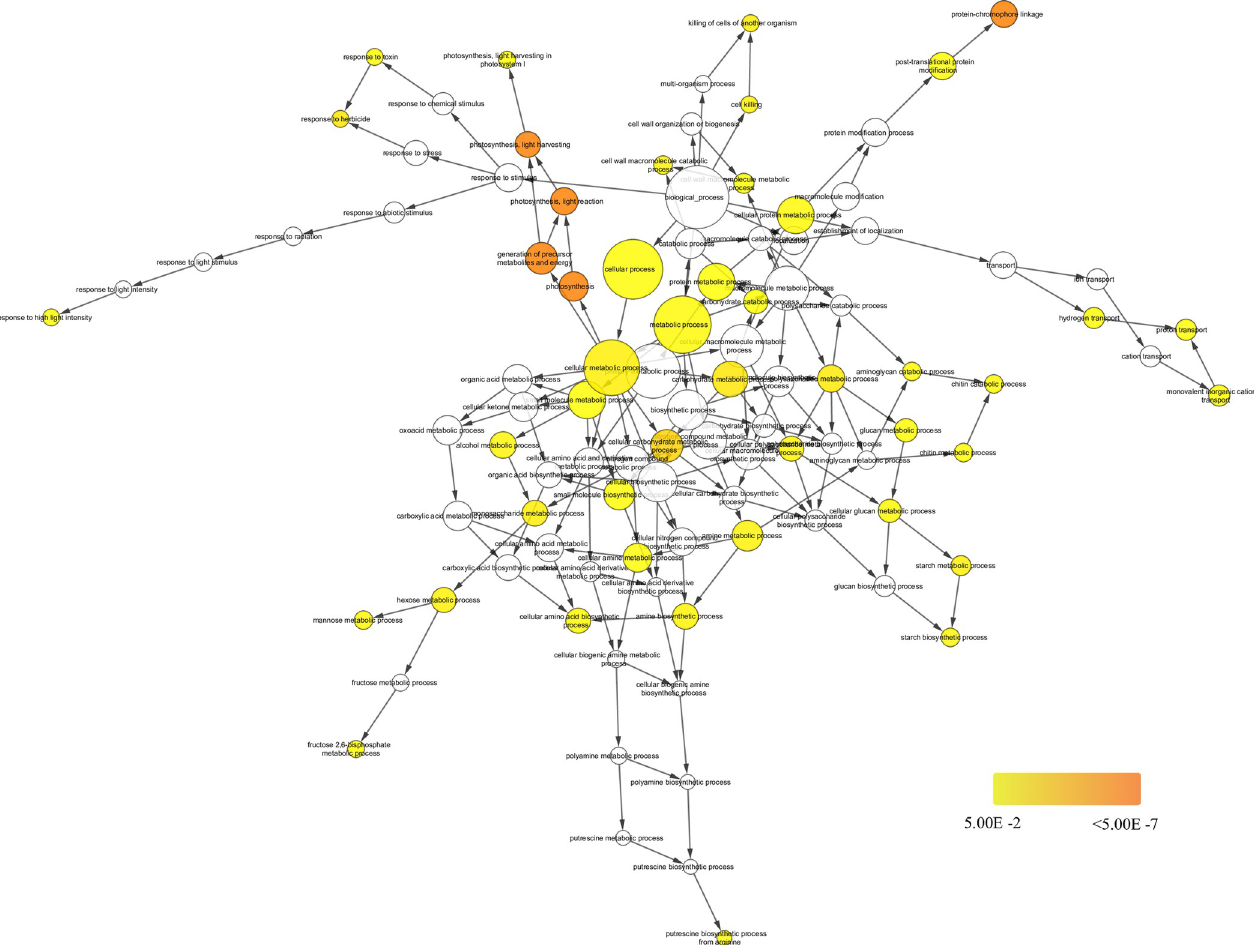
Fig 5. Network of GO terms of biological process showing the enriched terms for the unique genes of K2 (MI) genotype. Nodes represent the GO terms. Size of the nodes represents the number of gene and the colour represent significant value (See scale).